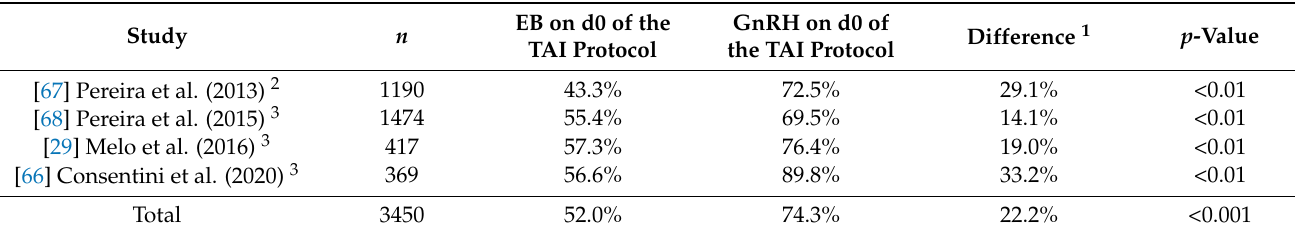
Table 1. Percentage of lactating dairy cows with a corpus luteum at the time of prostaglandin F2 α (PGF) treatment comparing timed artificial insemination (TAI) protocols that utilized only estradiol benzoate (EB) vs. protocols with gonadotropin releasing-hormone (GnRH) either alone or combined with EB.